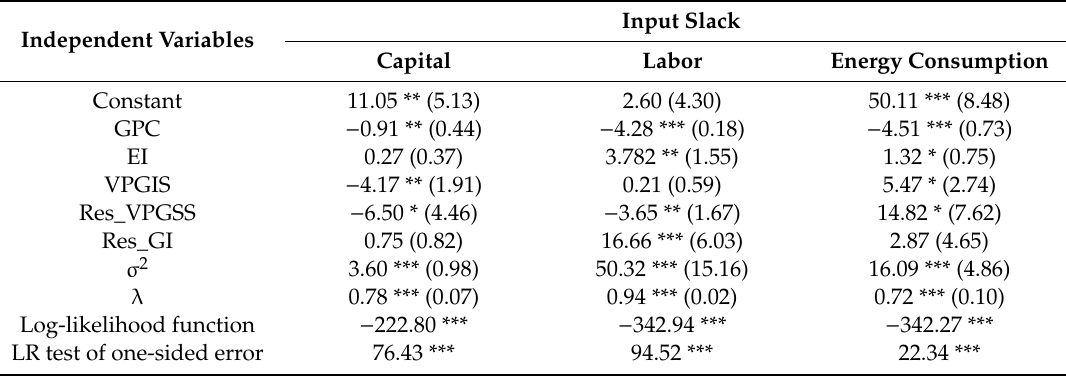
Table 4. Stochastic frontier estimation results (standard errors in